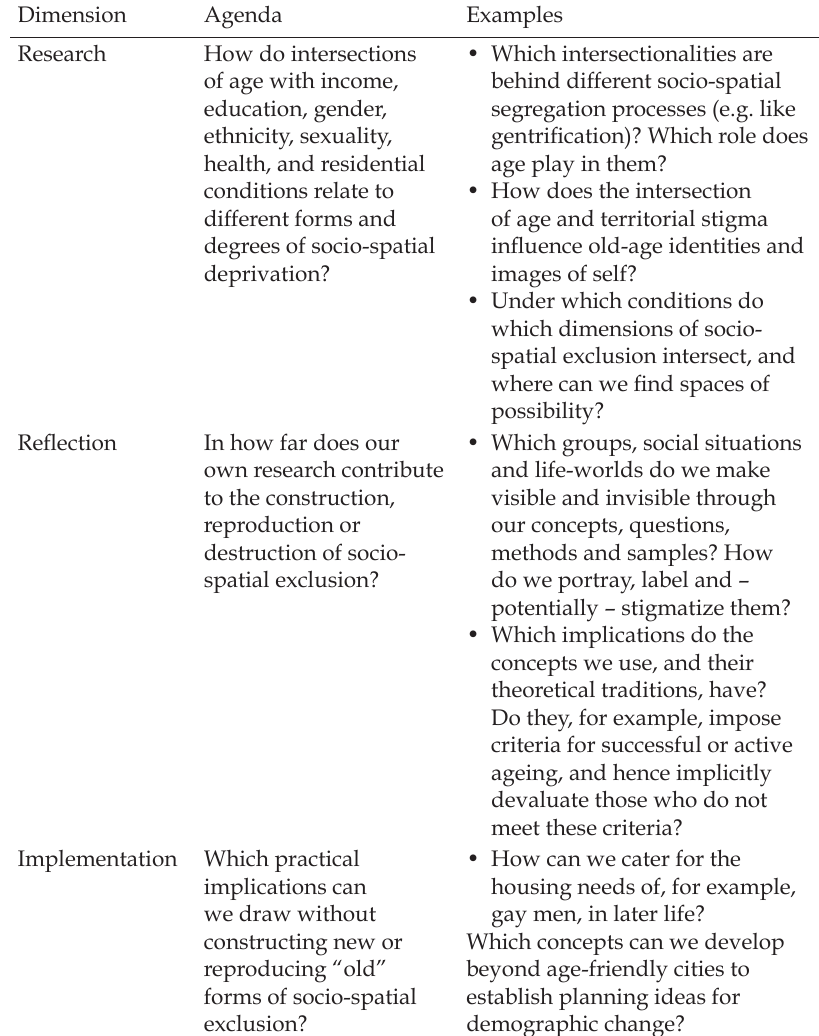
Table 1. A future research agenda for environmental gerontology